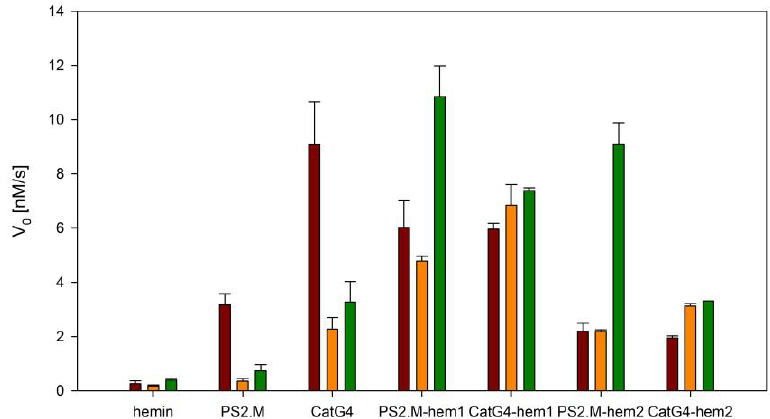
Figure 3. Catalytic activity of various enzymatic systems in an oxidation reaction of 2,2′-azino-bis(3-ethylbenzothiazoline-6-sulphonic acid) (ABTS) with hydrogen peroxide. The colors of the bars represent the reactions in the presence of potassium cations (brown) and sodium cations (orange), or in the absence of cations (green). Conditions: 0.5 µ M DNA, 0.5 µ M hemin (if present), 100 mM KCl or NaCl, 10 mM Tris-HCl (pH 8.0), 1 mM ABTS, and 1 mM H 2 O 2 . The values were averaged across three experiments.